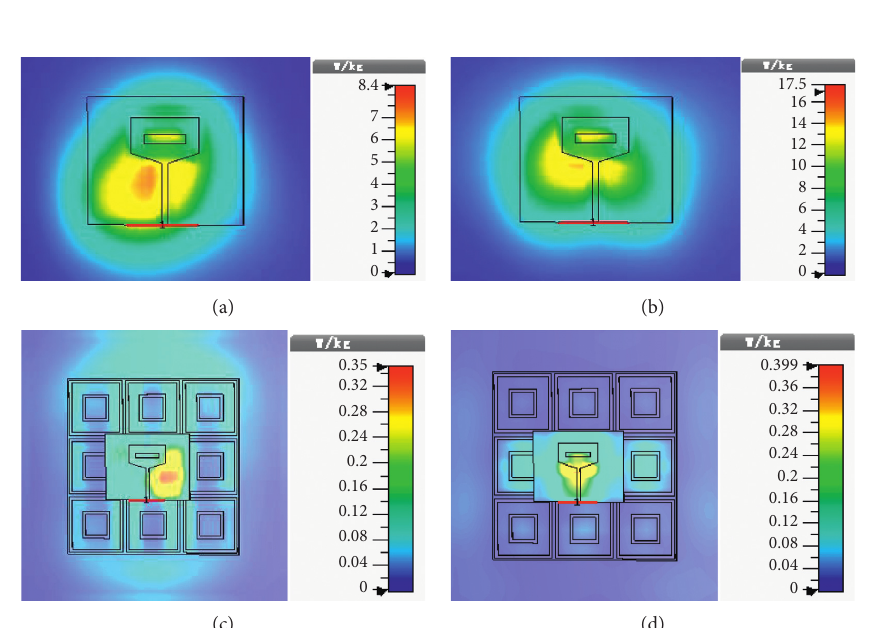
Figure 10: SAR value distribution of antenna: (a) monopole at 2.45 GHz, (b) monopole at 5.8GHz, (c) integrate at 2.45GHz, and (d) integrate at